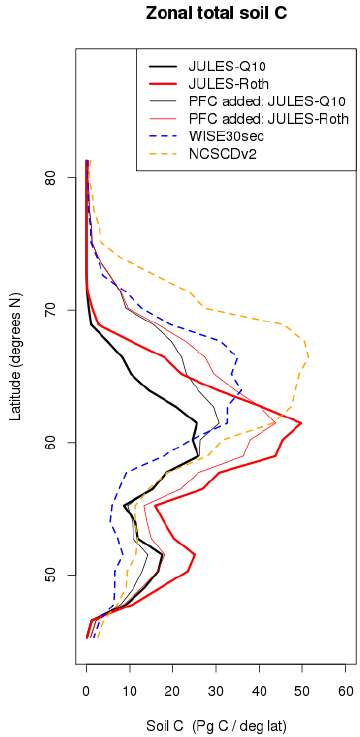
Figure 12. Zonal profile of total soil carbon after re-initialization with observed soil carbon at depths between 1 and 3m – com- pared with observations, and with the vertically resolved versions of JULES-Q10 and